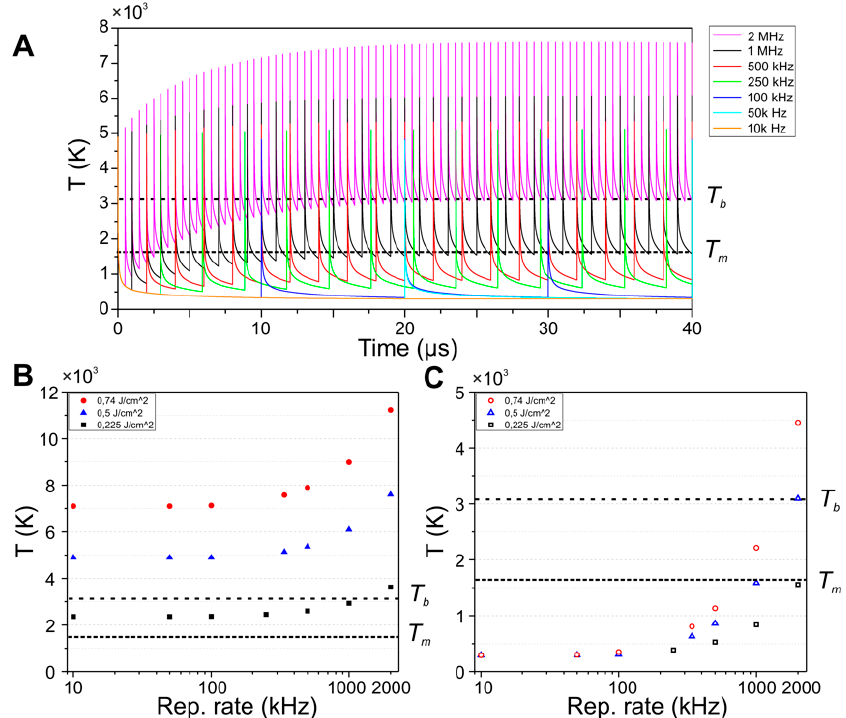
Figure 4. ( A) Temperature curves versus time for different repetition rates acquired in dynamic probe mode, showing multiple peaks that correspond to the arrival of a pulse over the moving temperature probe. The experimental parameters are the same of the experiment shown in Figure 5A ( φ = 0.5 J/cm 2 , and N eff 1D = 30); ( B ) peak temperature; and ( C ) base temperature from simulations for different repetition rates. The dashed lines in correspond to melting and boiling temperatures of steel of 1672 K [45] and ~3300 K